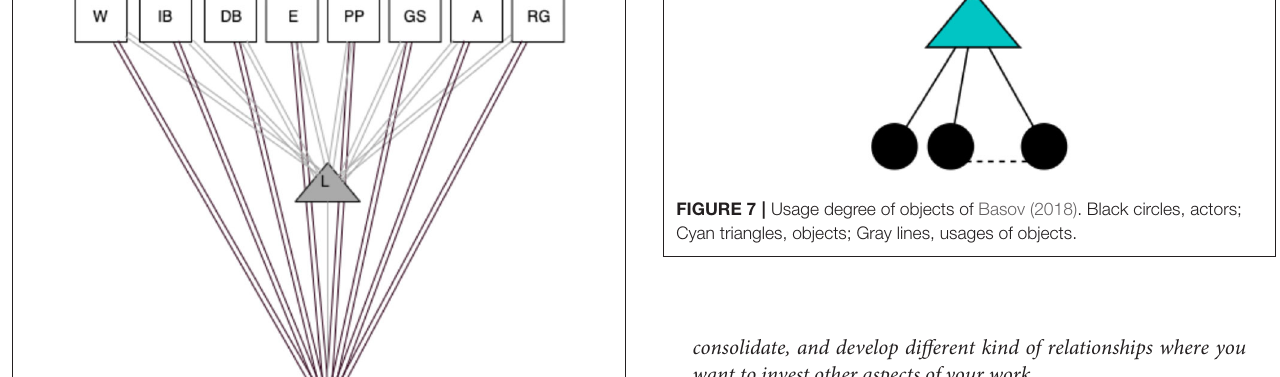
want to invest other aspects of your